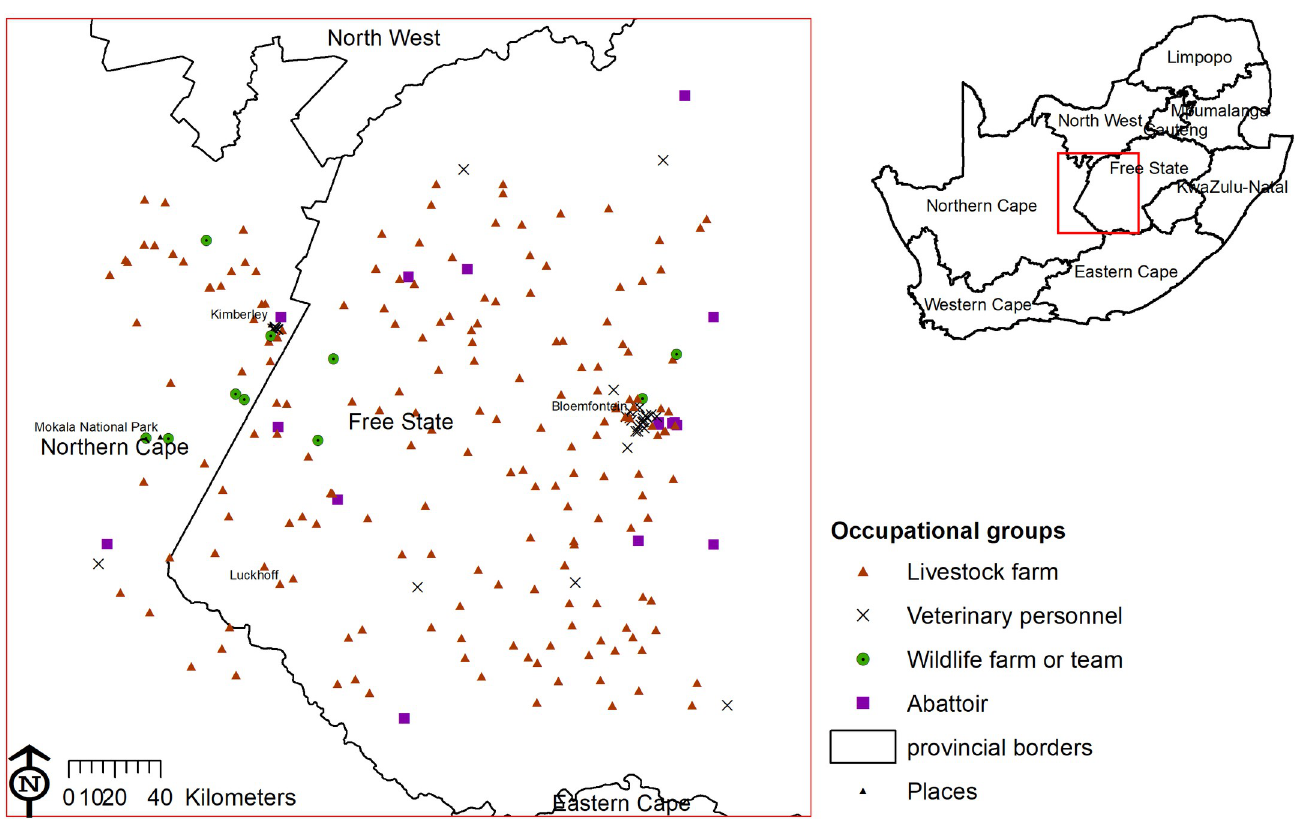
Fig 1. Study area showing human and animal sampling sites for Crimean-Congo haemorrhagic fever virus antibodies or RNA in central South Africa, 2017– 18. The map was constructed for the manuscript in Esri ARCGIS 10.2 using country and provincial boundaries from Municipal Demarcation Board [23] and National Geo-Spatial Information [24], coordinates of sampling sites and towns collected during the survey data available under a Creative Commons Attribution (CC BY 4.0) license.